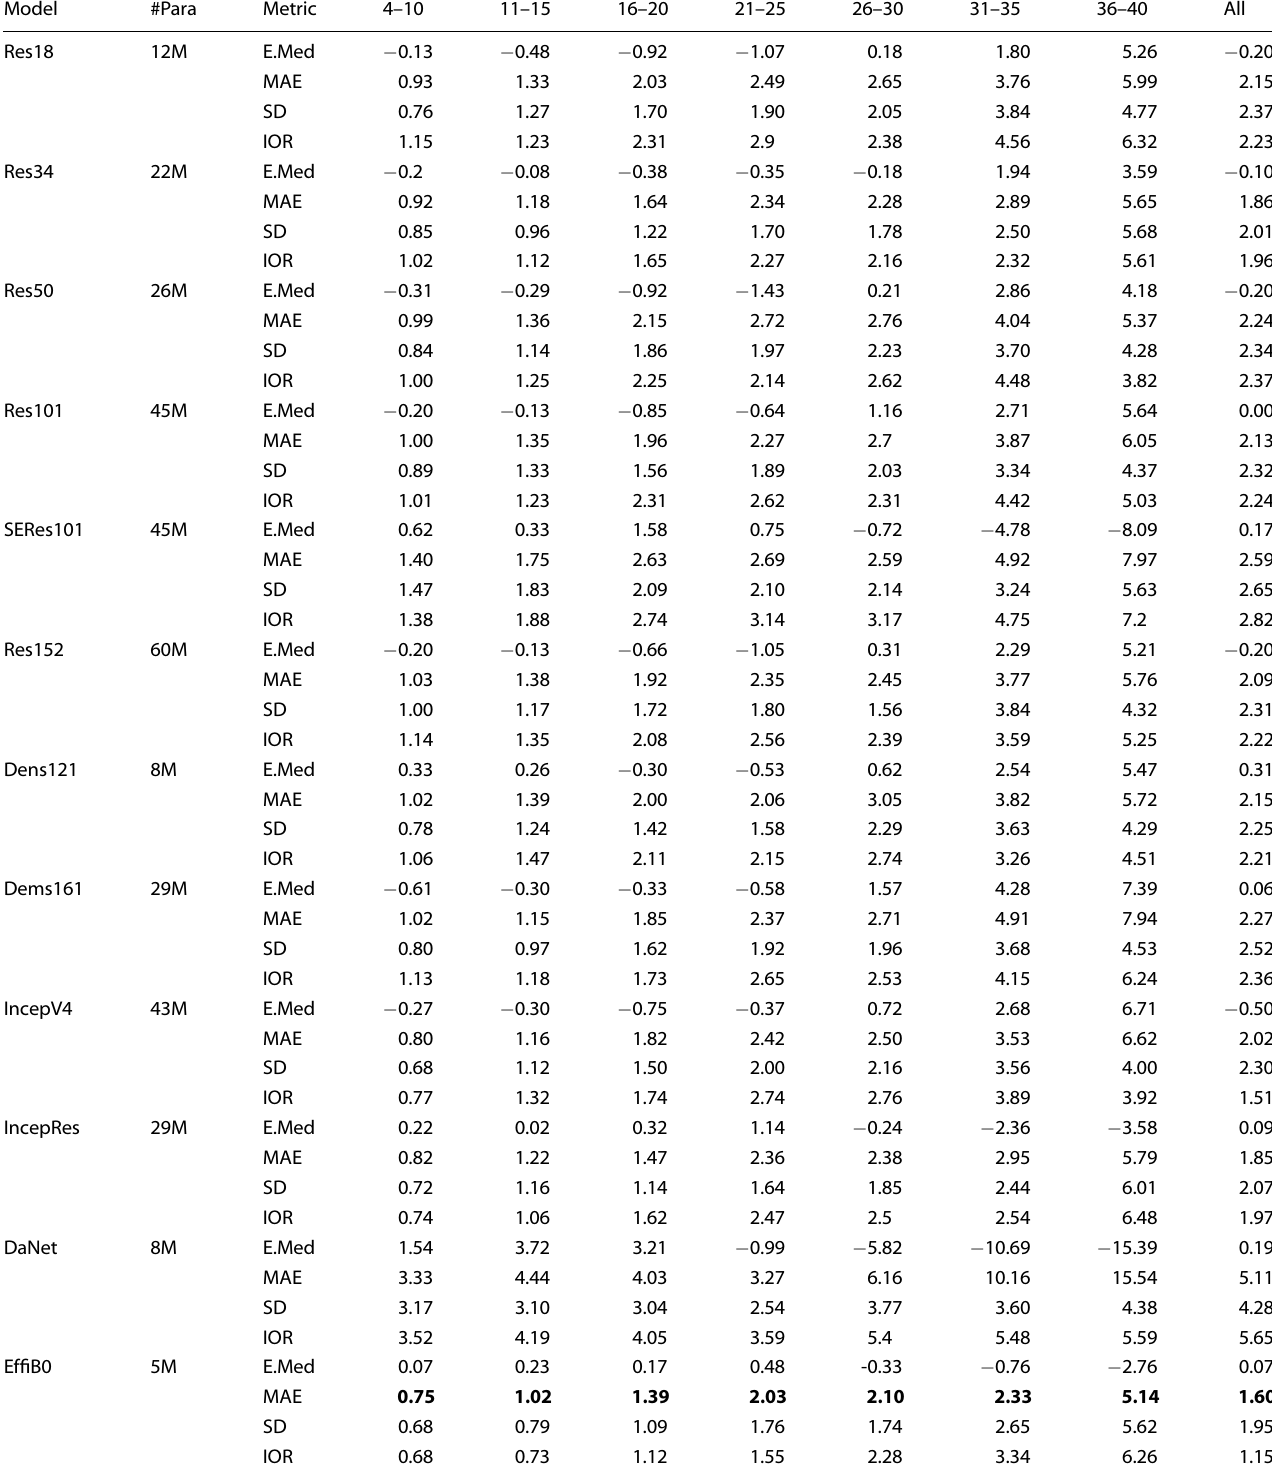
Table 5. Age estimation performance comparison of ageing feature extractors. Model Res18